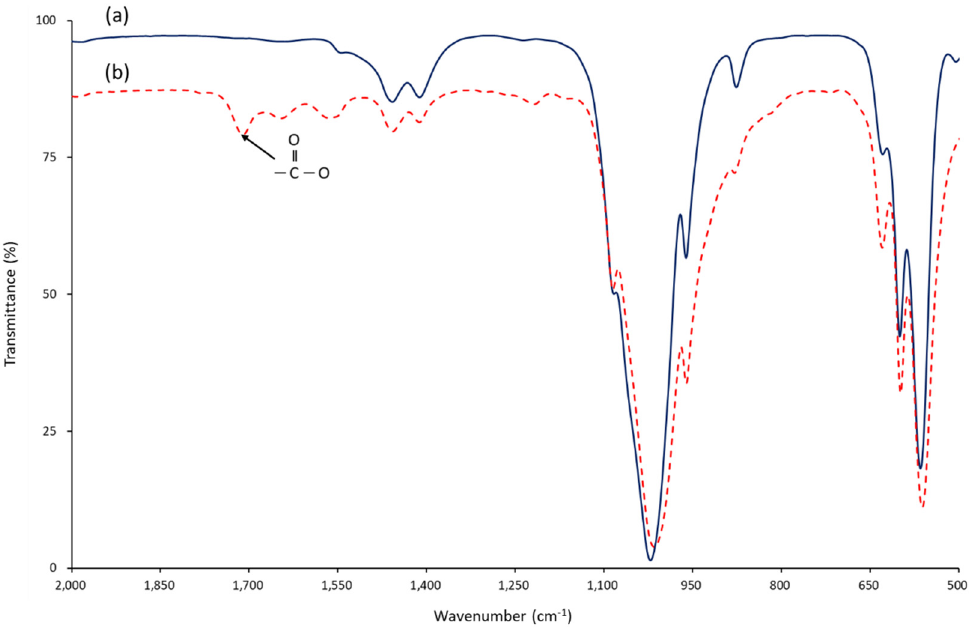
Figure 4. FT − IR spectra of ( a ) nHA and ( b ) succinic acid-grafted nHA (S-HA) measured by KBr disc method. When succinic acid reacts with the hydroxyl group of nHA, an ester bond is formed and free carboxylic acid remains. The success of the surface reaction can be known from the presence of carbonyl stretching vibration (1700 cm − 1 ) absorption in the IR spectrum.